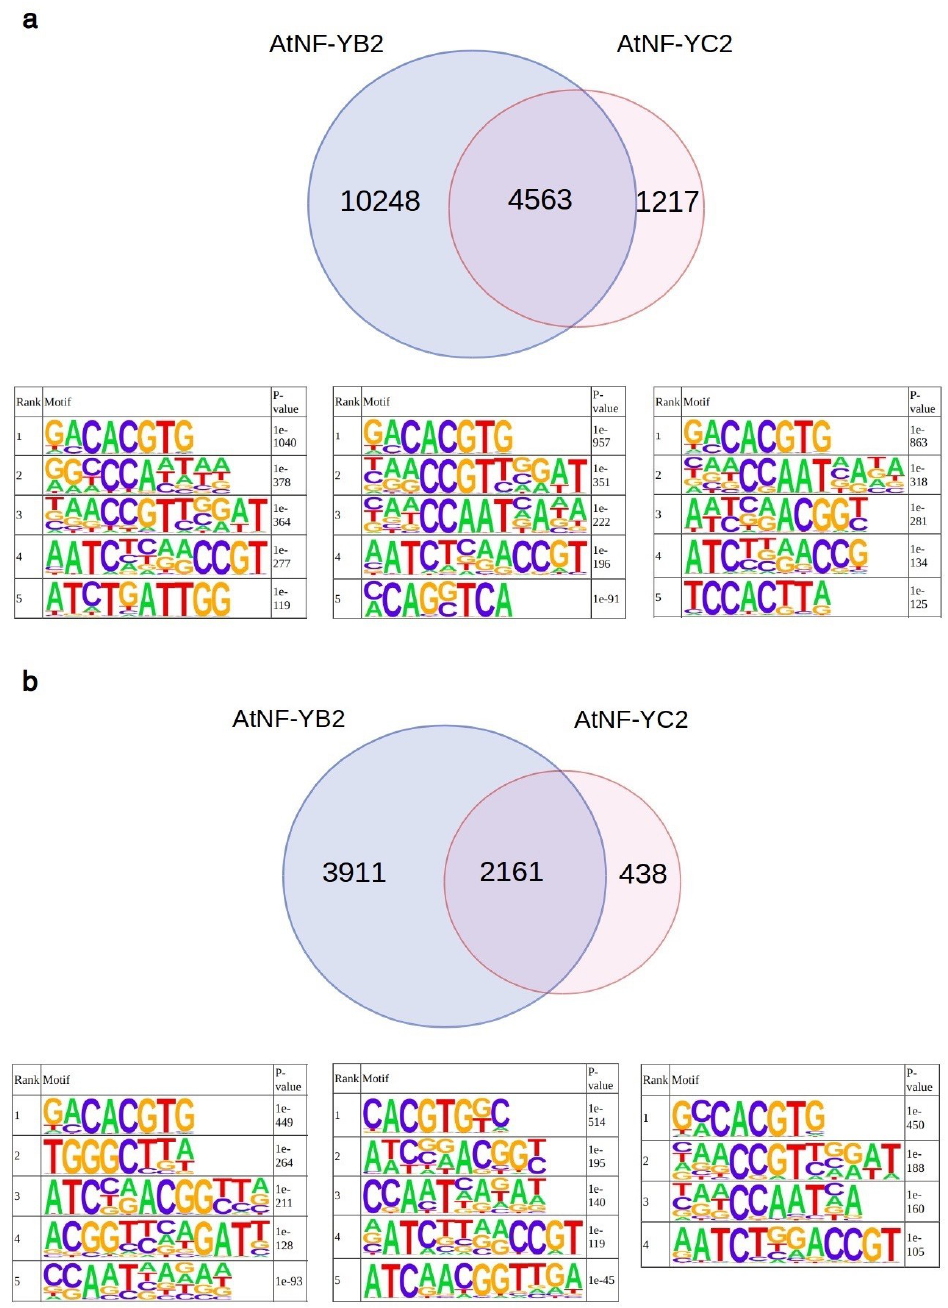
Figure 3. Analysis of AtNF-YB2 and AtNF-YC2 binding sites in vivo . Venn diagram displaying the number of peaks detected in the AtNF-YB2, AtNF-YC2 ChIP-Seq experiments and the number of shared peaks [31] with enriched motifs, as recovered by Homer ( p -value ≤ 10e − 30) for AtNF-YB2 (left), AtNF-YC2 peaks (right) and shared peaks (center). ( a ) All Peaks. ( b ) Peaks in promoter regions (defined as genomic intervals from − 500 bp to an annotated TSS).